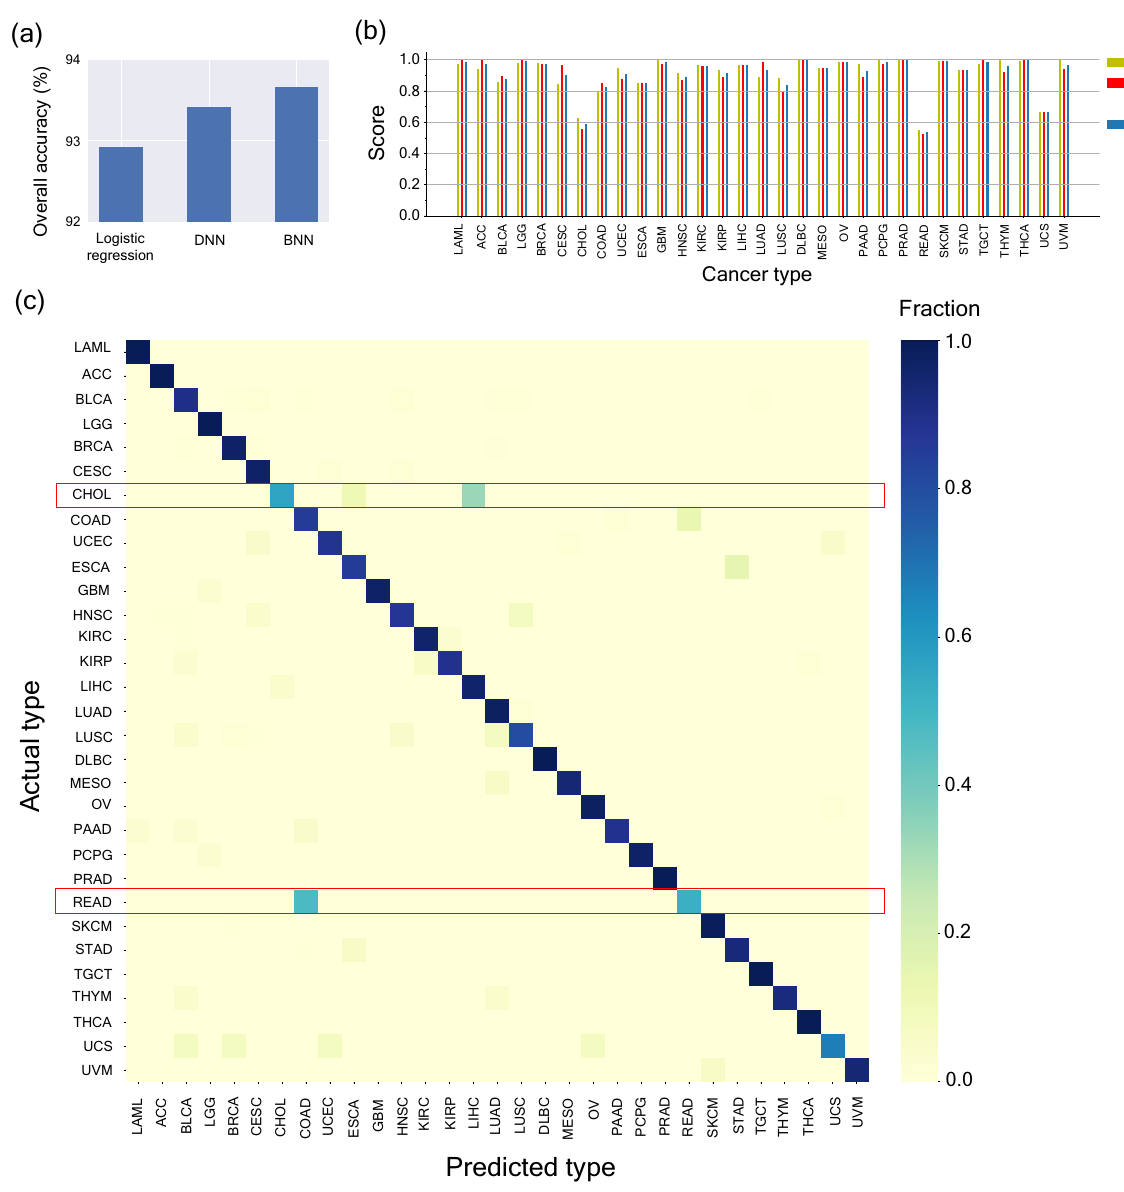
Figure 2. Classification of 31 different cancer types by a Bayesian neural network (BNN) ( a ) Overall Accuracy comparison of L2-regularized logistic regression, L2-regularized Deep Neural Network based classification method (DNN) and Bayesian Neural Network based classification method (BNN) ( b ) Precision, recall and F1 Scores of the cancer types for prediction of individual cancer types by the BNN. For classification of individual cancer types, recall represents accuracy of classification. ( c ) Confusion Matrix for the predictions of individual cancer types by BNN. The rows denote the actual cancer types and the columns denote the predicted cancer